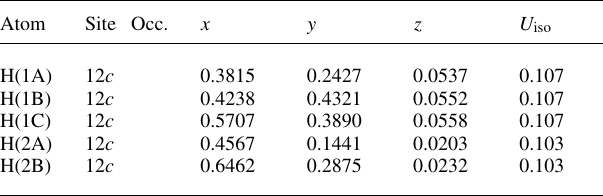
Table 2. Atomic coordinates and displacement parameters (in Å 2 ) .